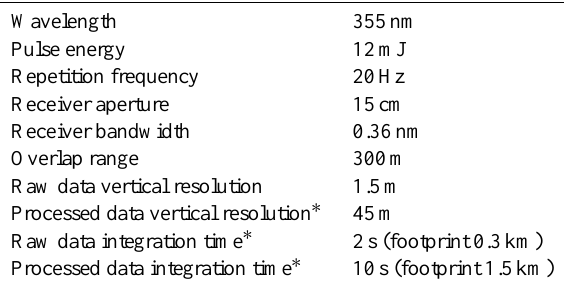
Table 1. Technical specifications of the Leosphere ALS450 lidar on board the FAAM aircraft. Footprints are computed for a typical aircraft speed of 150ms − 1